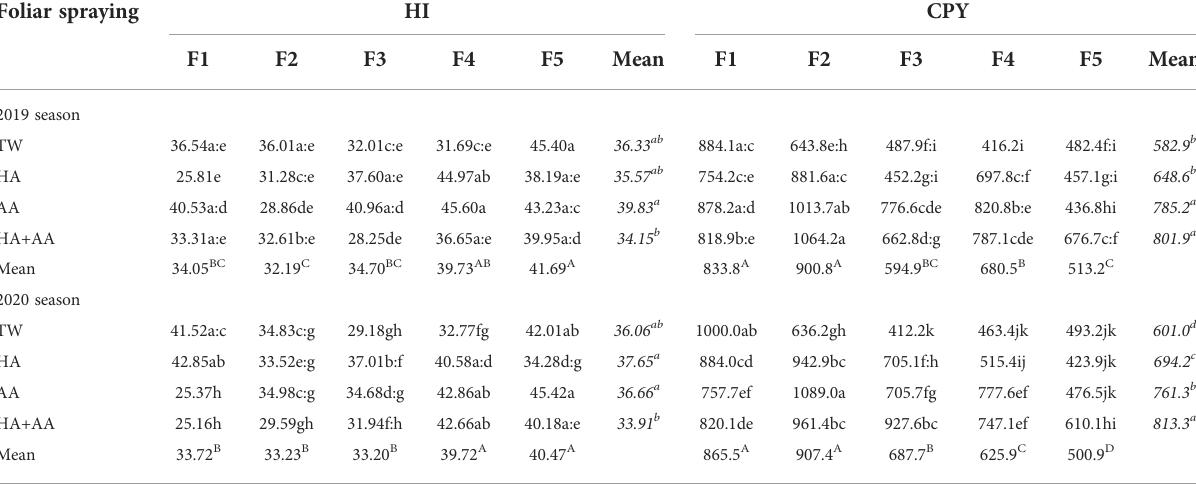
TABLE 4 Impact of foliar spraying of stimulants and chemical and bio fertilization treatments on harvest index and crude protein yield of maize. Foliar spraying